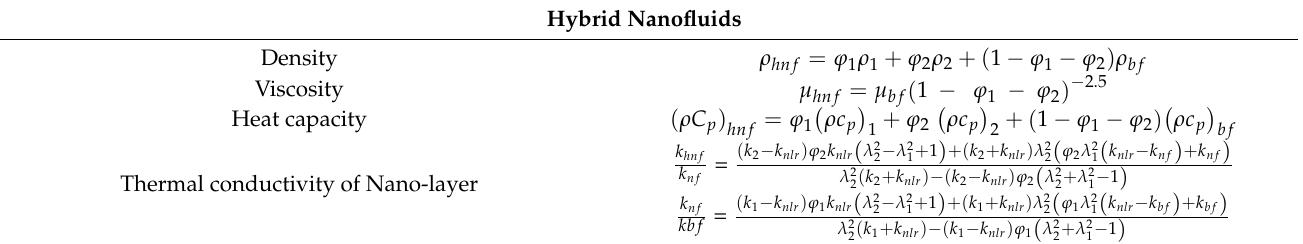
Table 2. Thermophysical properties of HNfl [38,39]. Hybrid